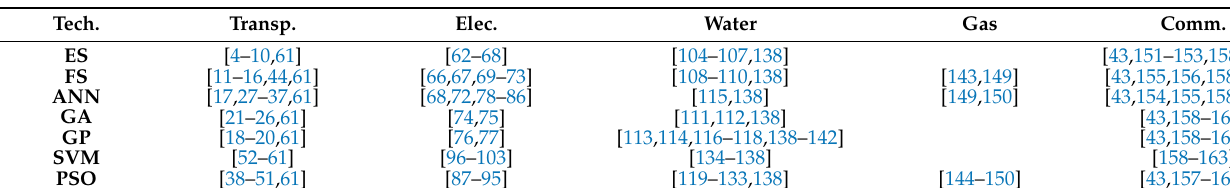
Table 3. Publications sorted with respect to subject and AI technique.